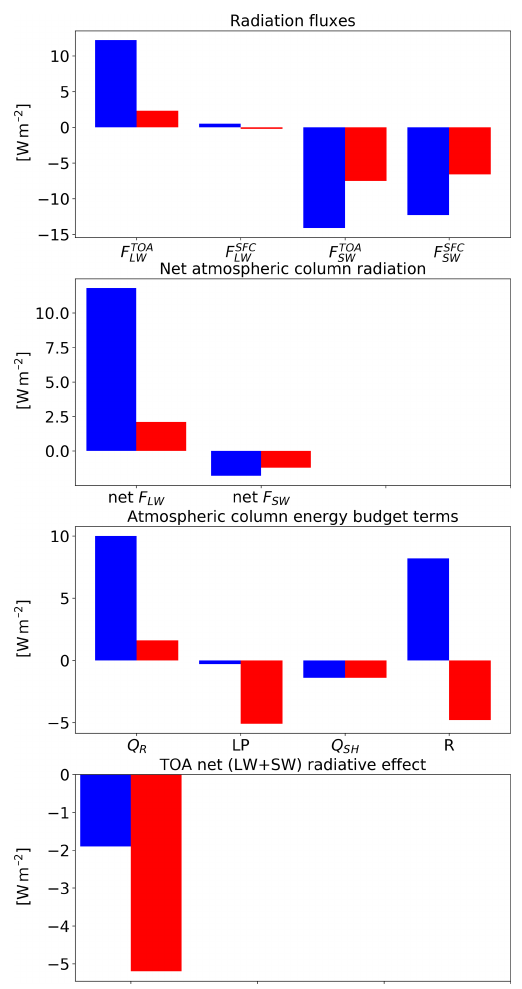
Figure 20. Summary of the radiation and energy response to CDNC perturbation in the two different cases. Blue represents the deep-cloud-dominated case, while red represents the shallow-cloud- dominated